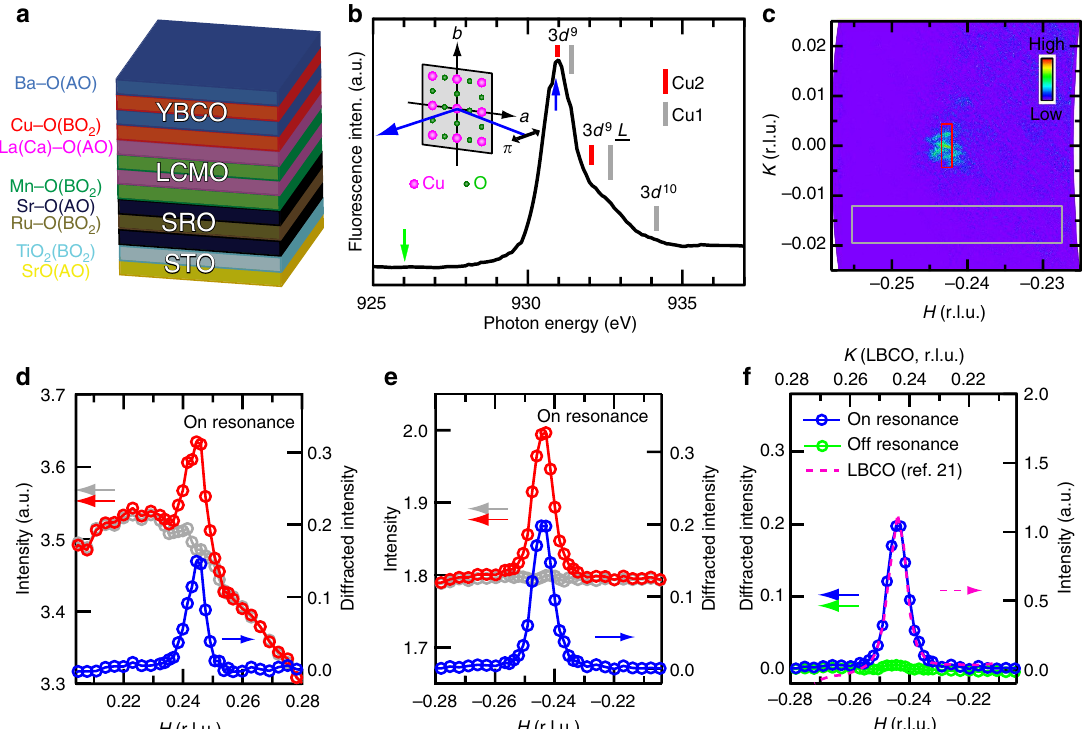
Figure 1 | In-plane component of the electronic supermodulation. ( a ) Schematic of the heterostructure in sample #1. The individual atomic layers (AO and BO 2 ) of the ABO 3 -type perovskite are indicated by different colours. ( b ) X-ray absorption spectrum measured near the Cu L 3 absorption edge in total fluorescence yield. Main configuration-dependent contributions to the spectrum are marked by red and grey bars as reproduced from ref. 13. Red and grey bars mark the energy positions of states derived from the Cu sites in the CuO 2 plane (Cu2) and those in the Cu–O chain layer (Cu1), respectively. Inset: schematic of the scattering geometry with linear ( p ) incident polarization in the horizontal scattering plane. ( c ) In-plane reciprocal space projection derived from a single CCD image measured at 930.85eV (indicated by blue arrow in b ) showing a diffraction peak near ( (cid:2) 0.245, 0, 1.38). Note that the raw image contains the L range from B 1.31 to B 1.45, and only its projection onto the ( H , K , 0) plane is shown here. ( d , e ) Scattered intensity line cuts along H measured at 50K and 930.85eV at fixed L ¼ 1.38 and K ¼ 0. Each point on the red (grey) curve indicates average intensity in the region of the corresponding CCD image marked by the red (grey) rectangle in c . Blue curve is the difference between red and grey curves showing the diffracted intensity. The intensity in e and diffracted intensity in d – f all share the same scale with the intensity in d . ( f ) Diffracted intensity measured at 926eV (green curve, indicated by the green arrow in b ) and 930.85eV (blue curve, reproduced from e ) at fixed L ¼ 1.38 and K ¼ 0, compared alongside the K scan of La 1.875 Ba 0.125 CuO 4 (reproduced from ref. 21; note that equivalent modulations exist along both the H and K directions in the low-temperature tetragonal phase of La 1.875 Ba 0.125 CuO 4 ). All results were obtained from sample #1. r.l.u., reciprocal lattice units. NATURE COMMUNICATIONS|7:10852|DOI: